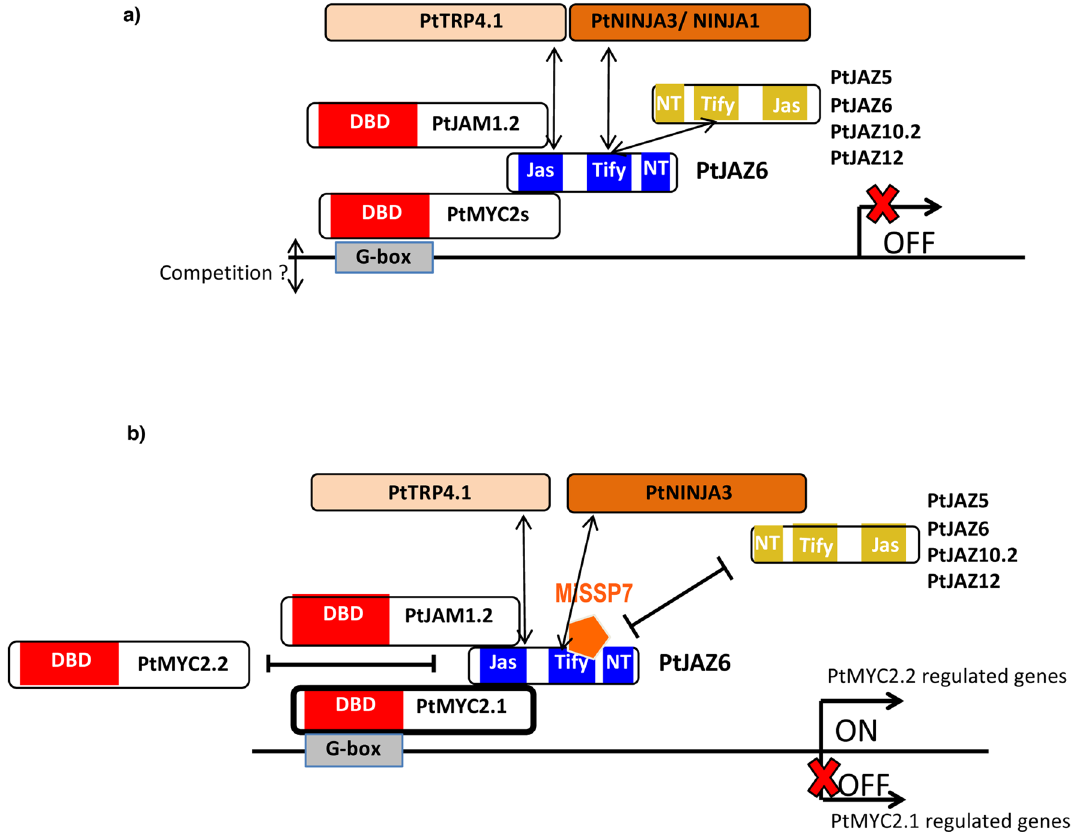
Figure 6. PtJAZ6-interacting proteins in Populus ectomycorrhizal root tips. ( a ) PtJAZ6 physically interacts with the transcription factors PtMYC2s and PtJAM1s, as well as with PtTPR4.1, NINJA1 and NINJA3. It also forms homodimers and heterodimers with PtJAZ5, PtJAZ10.2 and PtJAZ12. PtJAZ6 probably suppresses the transcriptional activity of PtMYC2s and PtJAM1s by recruiting the general repressor PtTPR4.1 to the promoter of MYC2-responsive genes. ( b ) The fungal symbiotic effector MiSSP7 interacts with PtJAZ6 12